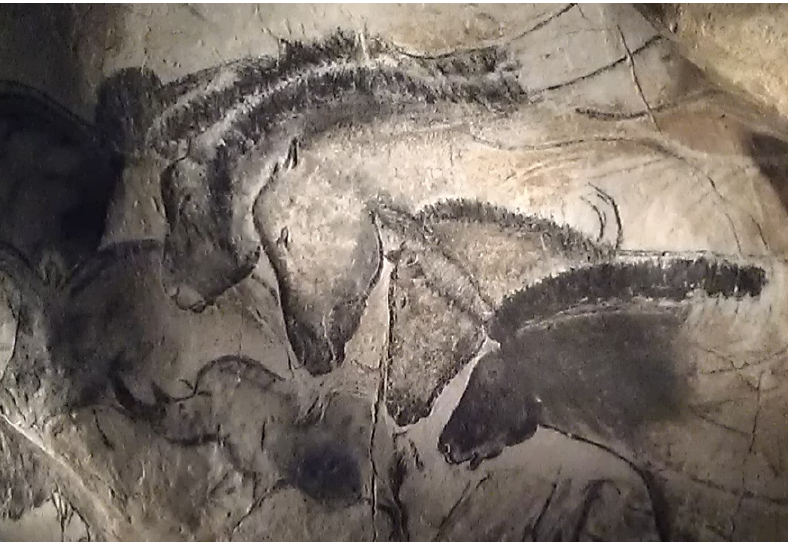
Figure 2. Group of Chauvet Cave Drawings. By Nachosan - Own work, CC BY-SA 3.0,